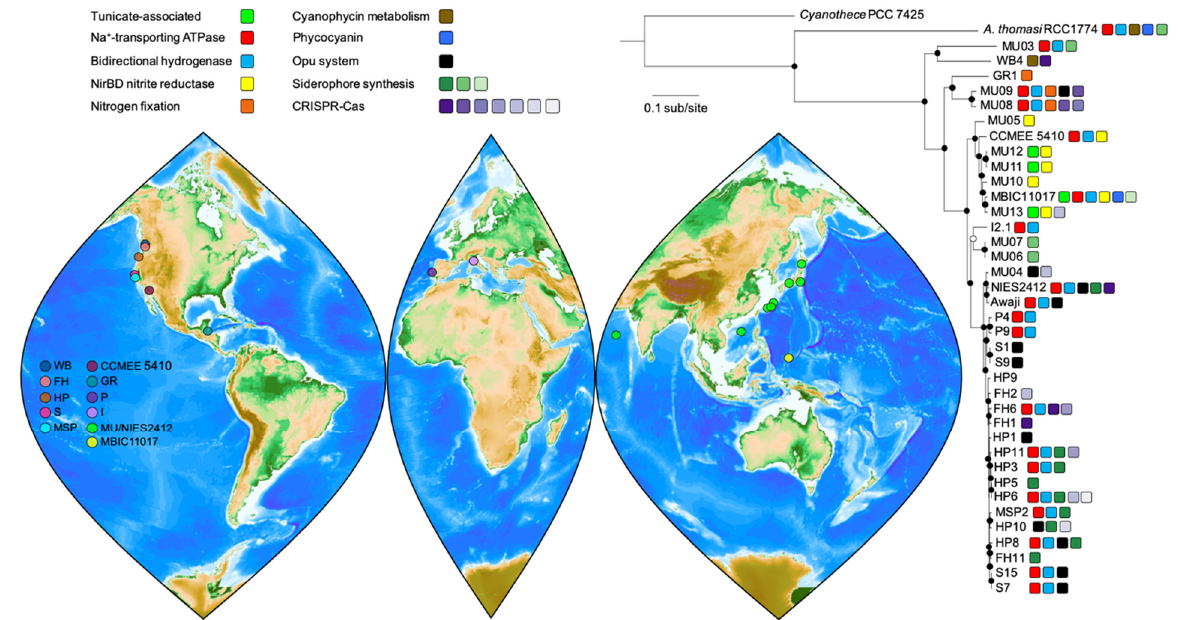
Figure 1. Sampling locations for A. marina strains and their evolutionary relationships. The genome- wide maximum likelihood phylogeny was reconstructed for a concatenation of 1369 protein sequences from single-copy orthologs according to the JTT+F+R5 model of sequence evolution and outgroup-rooted with Cyanothece sp. PCC 7425. Branch lengths are in units of the expected number of amino acid substitutions per site. Bootstrap support values of 100% (closed circles) and >90% (open circle) are shown for 1,000 ultrafast bootstrap replicates. Selected traits discussed in the text are color coded as indicated. For the map of collection sites, note that the markers for the S. China Sea and Arabian Sea strains are approximate, as the exact sampling locations are unknown.